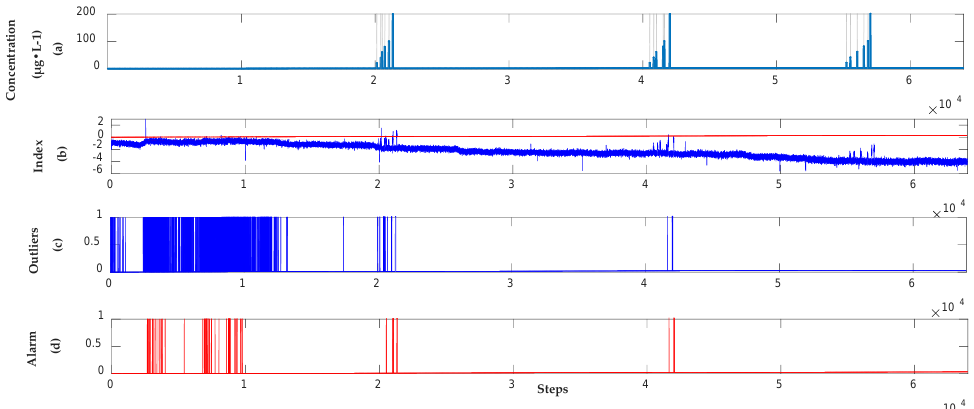
Figure 14. Results of the 23-days’ m-phenylenediamine detection in the supervised model. ( a ) Location and concentration of each event; ( b ) Alarm signals, which exceeded the threshold shown as the red dotted line; ( c ) Outliers obtained by using SVR; ( d ) Alarm sequences triggered by Sequential Bayesian.